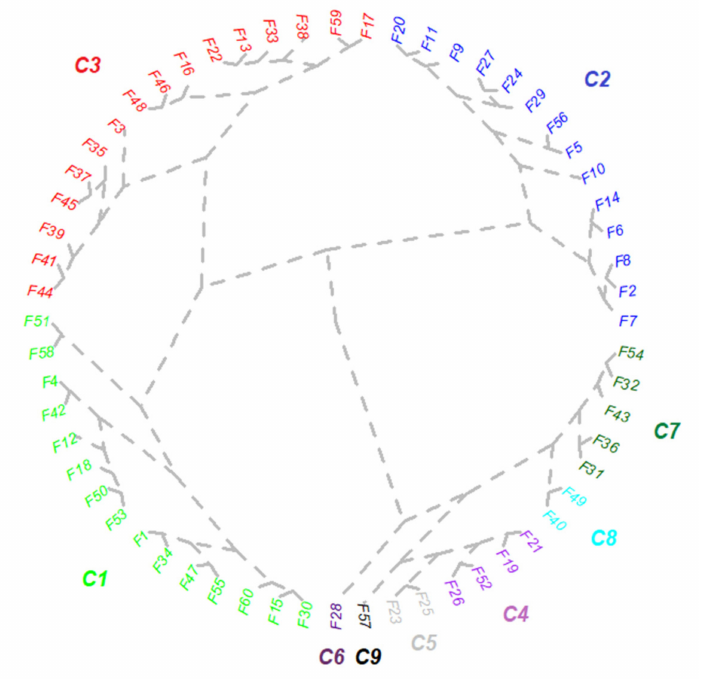
Figure 5. Cluster analysis of the mycorrhizal strategy based on the colonization mechanism in the roots of Festuca rubra . Each cluster is defined by the similarity between colonization parameters, with the best solution resulting in nine clusters. F followed by a number, Festuca rubra and the segment number (1–60). The conceptual hypothesis is that each segment may represent a specific colonization pattern, and based on linkages, each cluster defines a colonization strategy with similar colonization patterns (detailed in Table